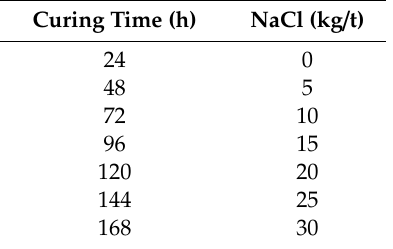
Table 2. Experimental levels of explanatory